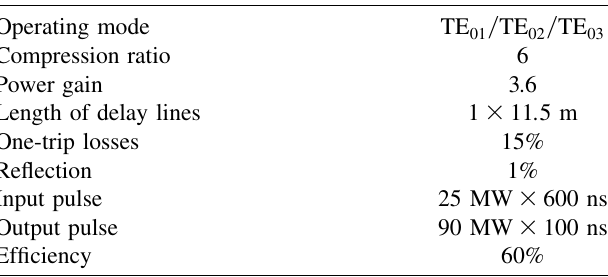
TABLE I. Design parameters of the 34 GHz OC SLED-II pulse compressor.